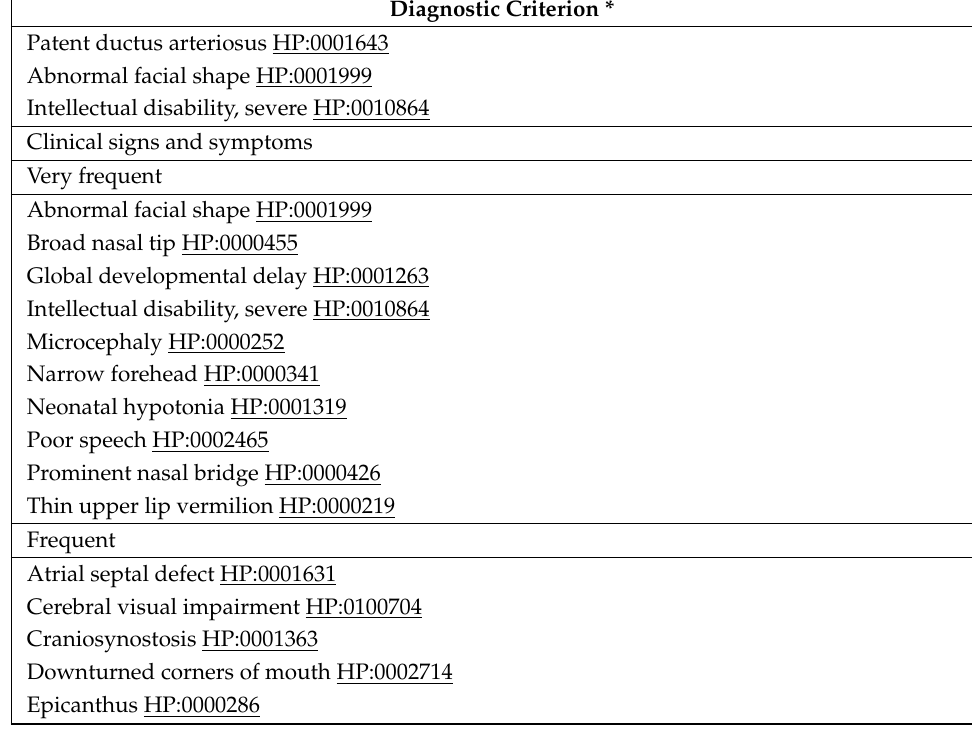
Table 1. ORPHA:457193 Autosomal dominant intellectual disability craniofacial-anomalies-cardiac defects syndrome. The phenotypic description of this disease is based on an analysis of the biomedical literature and uses the terms of the Human Phenotype Ontology (HPO). Phenotypic abnormalities are presented by order of frequency of occurrence in the patient population, then by alphabetical order inside each frequency group. * Phenotypic abnormalities noted as “diagnostic criterion” are those included in established sets of criteria to establish the diagnosis of a particular disease having been published in a peer-reviewed